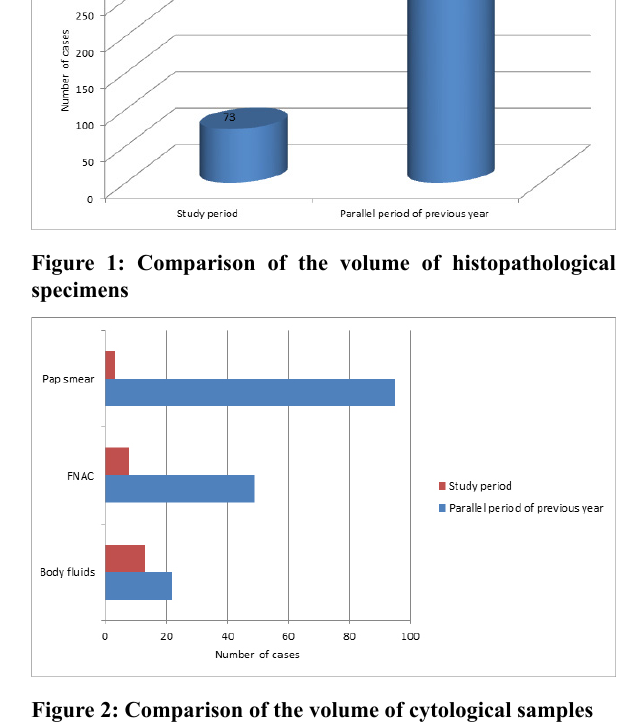
Figure 2: Comparison of the volume of cytological samples